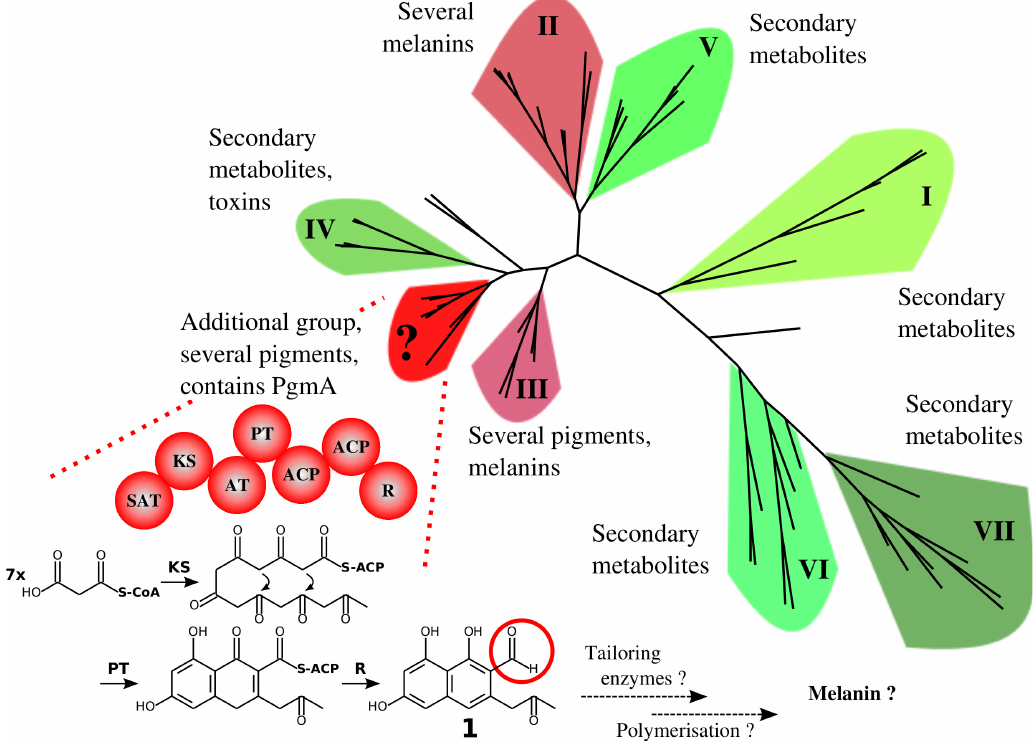
Figure 4. A phylogenetic scheme of various non-reducing polyketide synthases amongst Ascomycota phylum, dividing into eight groups based on the similarity of the ketosynthase domain sequences. The suggested hypothetical action mechanism for the majority of the NR-PKS enzymes amongst the additional group is as proposed by Awakawa et al., resulting in the intermediate 1; 3-acetonyl-1,6,8-trihydroxy-2-naphthaldehyde [38]. See a more detailed Figure S5 for the included NR-PKS proteins. The group classification of I-VII is based on the classes presented in the study of Ahuja et al., and the range of NR-PKS enzymes included in this analysis is based on the studies of Studt et al. and Ahuja et al. [37,45]. The extracted ketoacyl synthase domains of the polyketide synthases were compared and aligned to obtain the phylogram as described in our related study [22]. No outgroup was used. The protein sequences were obtained from the following databases: NCBI RefSeq, GenBank, DDBJ, EMBL and